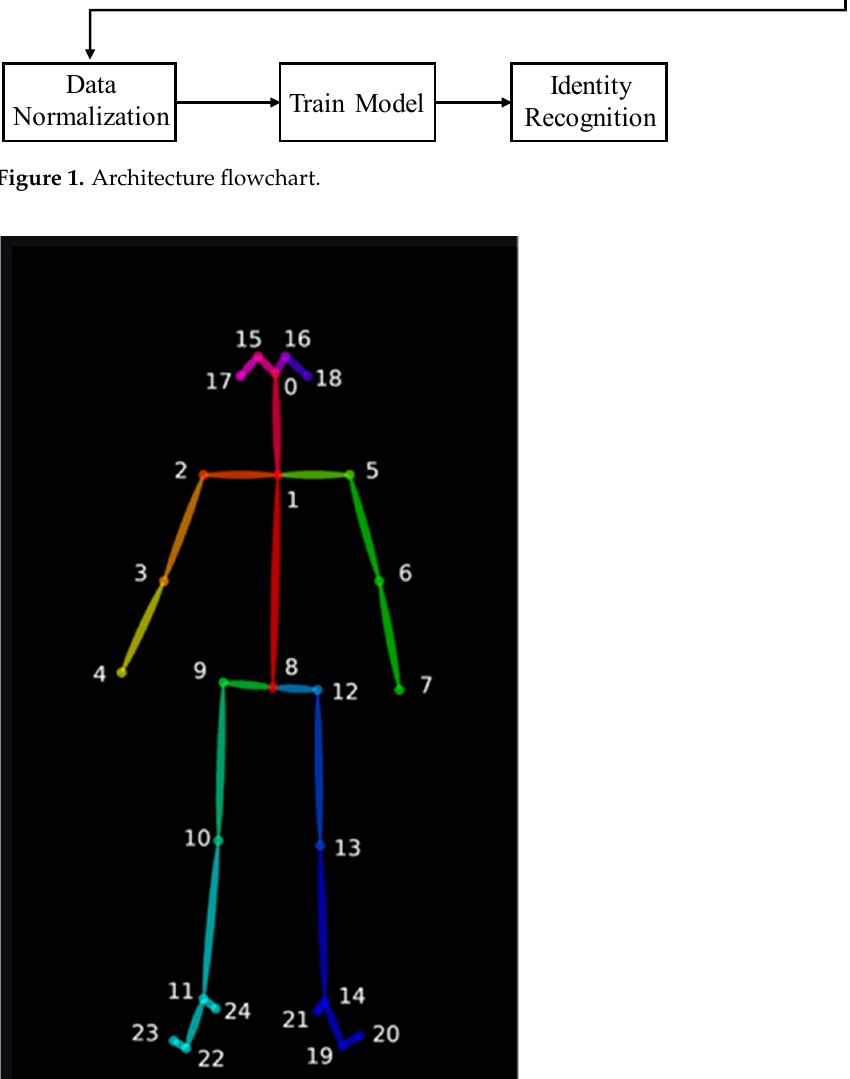
Figure 2. Twenty-five feature points were detected by OpenPose [17]. The points represent as follows: 0 is the nose; 1 is the neck; 2 is the right shoulder; 3 is the right elbow; 4 is the right wrist; 5 is the left shoulder; 6 is the left elbow; 7 is the left wrist; 8 is the middle hip; 9 is the right hip; 10 is the right knee; 11 is the right ankle, 12 is the left hip; 13 is the left knee; 14 is the left ankle; 15 is the right eye; 16 is the left eye; 17 is the right ear; 18 is the left ear; 19 is the left big toe; 20 is the left small toe; 21 is the left heel; 22 is the right big toe; 23 is the right small toe; 24 is the right heel.